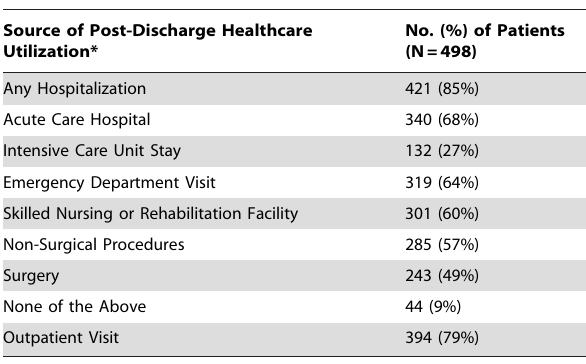
Table 3. Post-Discharge Healthcare Utilization in Year Following Detection with Methicillin-Resistant Staphylococcus aureus